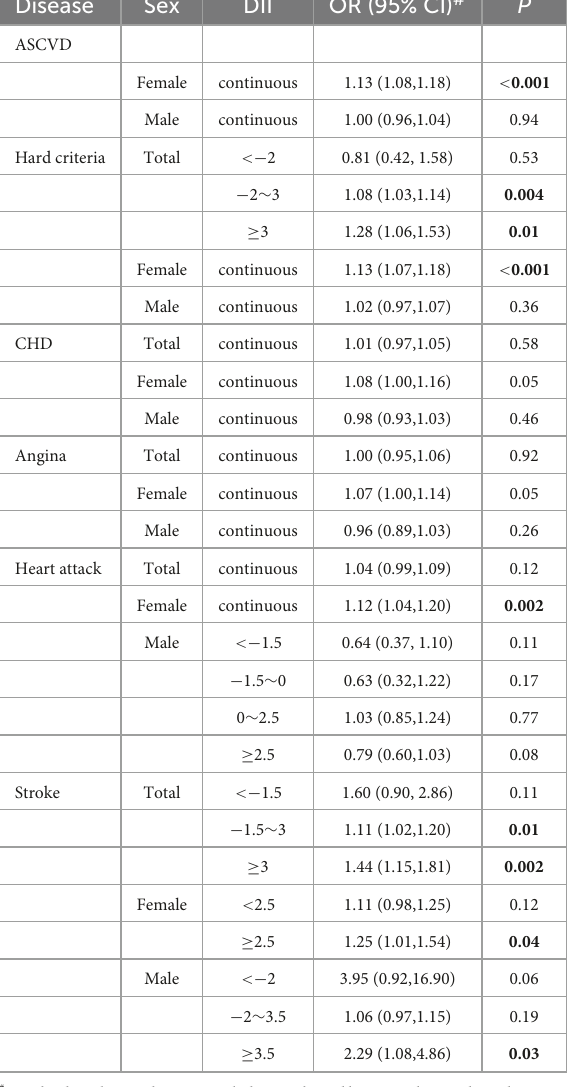
# Weightedresults.Hardcriteria:includingstrokeandheartattack.Weadjustedage,sex, race or ethnicity, body mass index, education level, smoking status, poverty, insurance, hyperlipemia,hypertension,anddiabetes.Boldrepresents P <